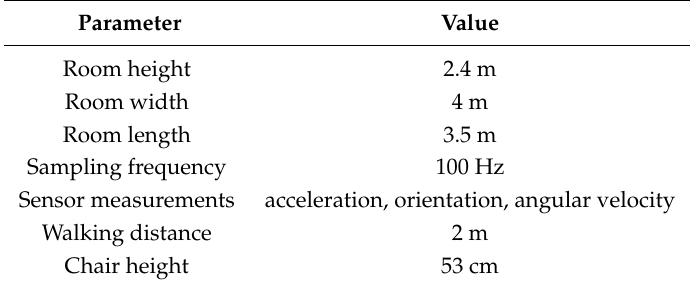
Table 1. Physical parameters of the experimental